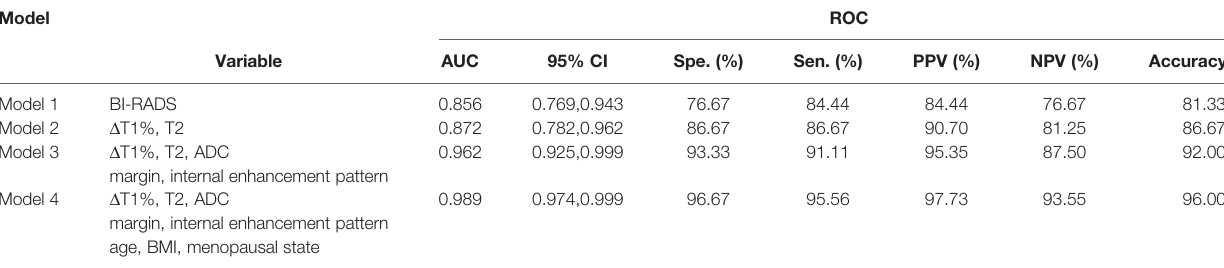
TABLE 5 | Diagnostic performance of different prediction models in the diagnosis of breast cancer and benign diseases.